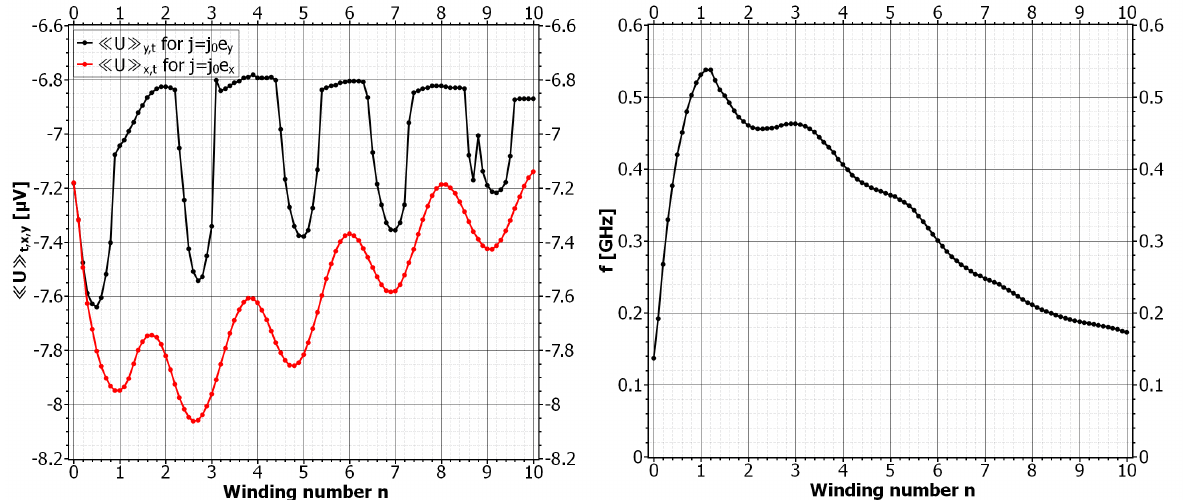
Figure 8. Left: Mean voltage versus winding number for α = α s and a transport current in the y-direction (upper curve) and x-direction (lower curve). For j e = j e e y vortices are forced to move along k and experience subsequent phases of pinning and motion depending on n . For j e = j e e x vortices move transverse to k and no pinning is observed for positive winding numbers. Right: Frequency of the voltage oscillations for j e = j e e x depending on the average vortex number and the time a vortex resides in the